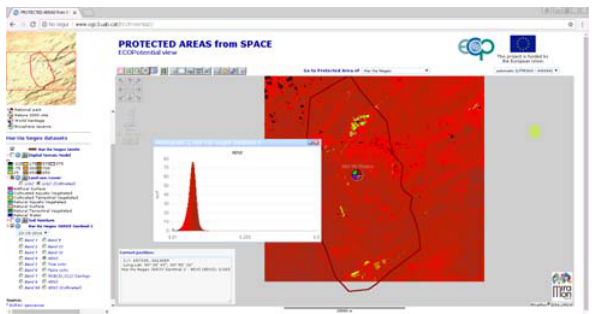
Figure 13. NDVI histogram over the Har Ha Negev Protected Area.